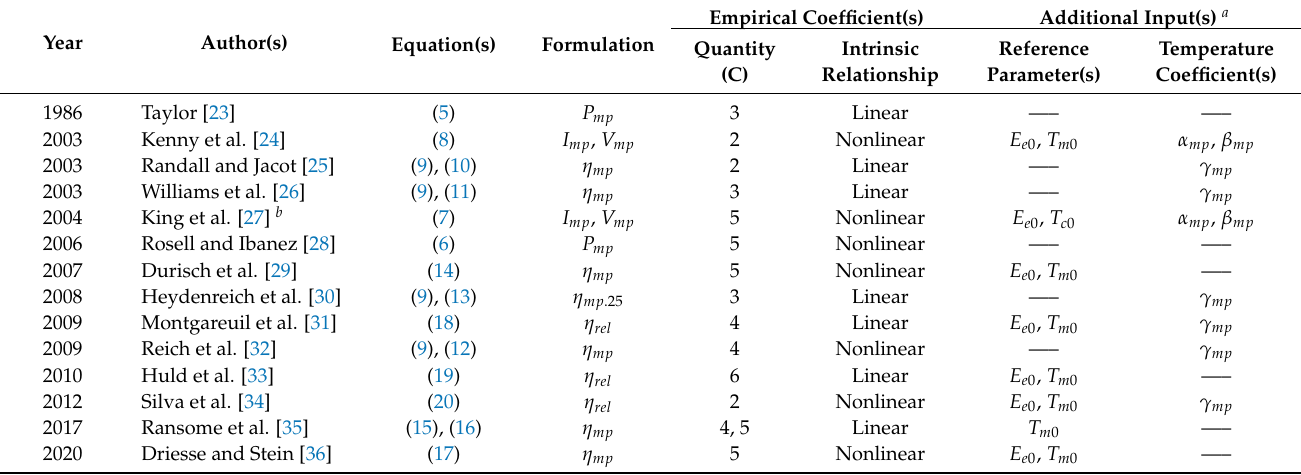
Table 1. Overview of the reviewed empirical